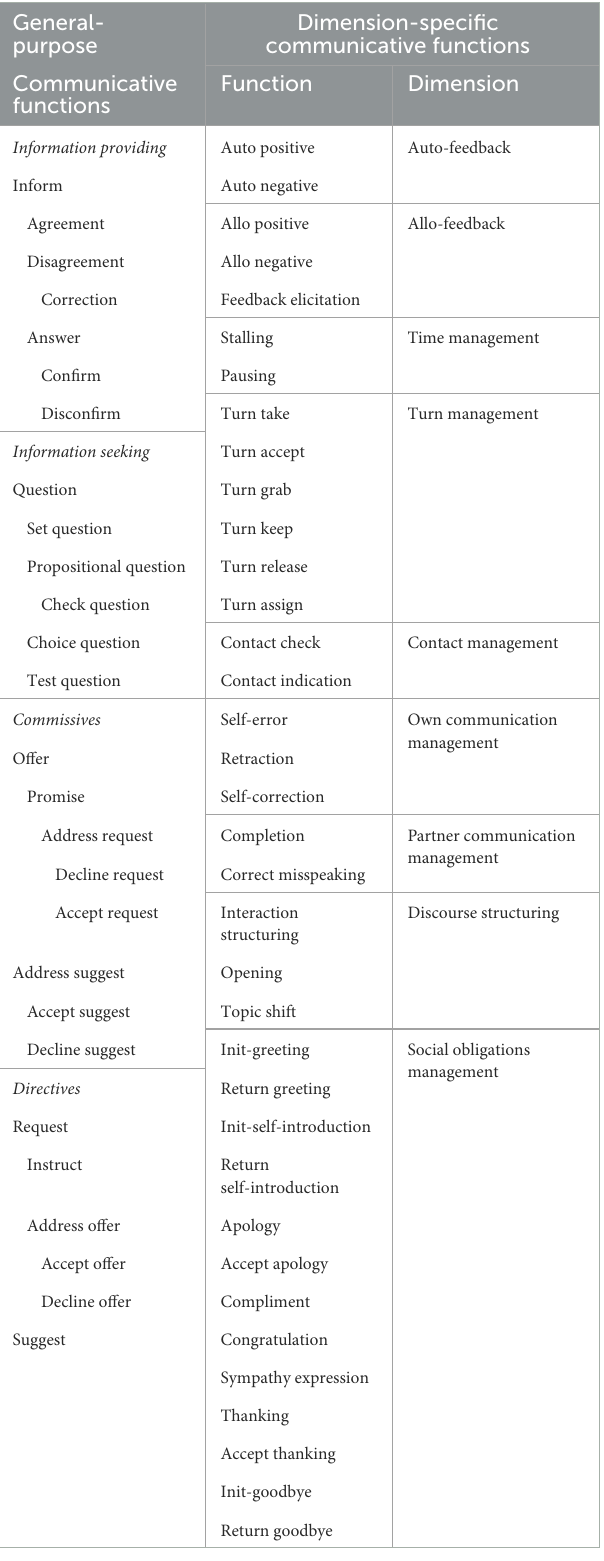
TABLE 1 ISO 24617-2 communicative